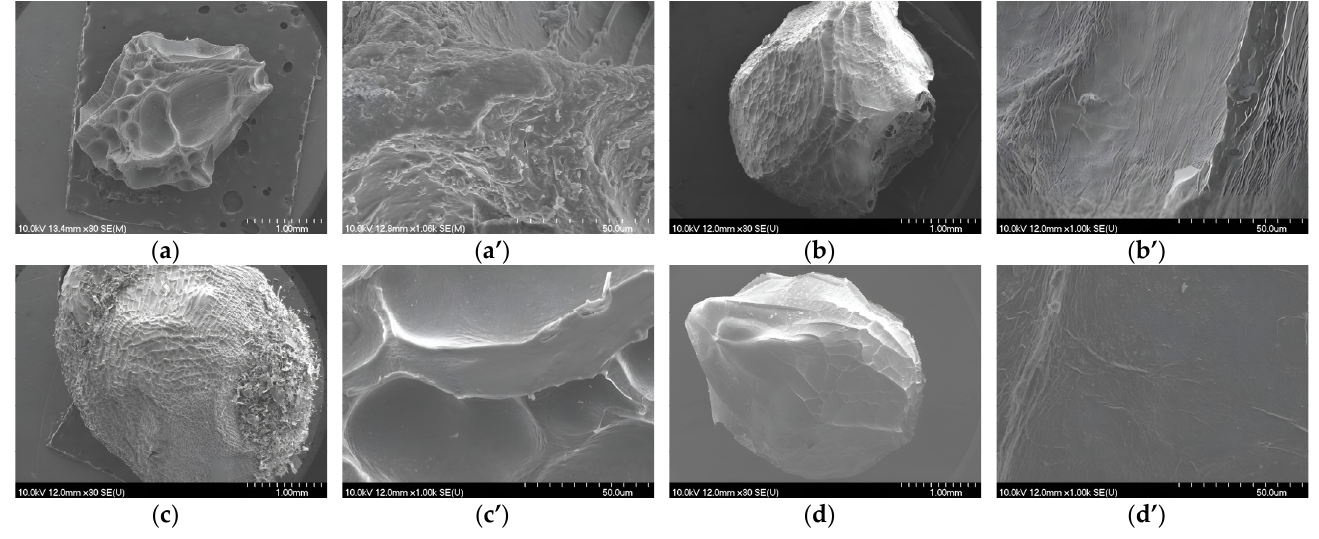
Figure 3. SEM images of freeze-dried microbeads of sodium alginate ( a , a ′ ); sodium alginate with gum arabic ( b , b ′ ), with gelatin ( c , c ′ ) and with chitosan ( d , d ′ ); and their outer layer with the scale bar of 1 mm and 50 µm for each sample.